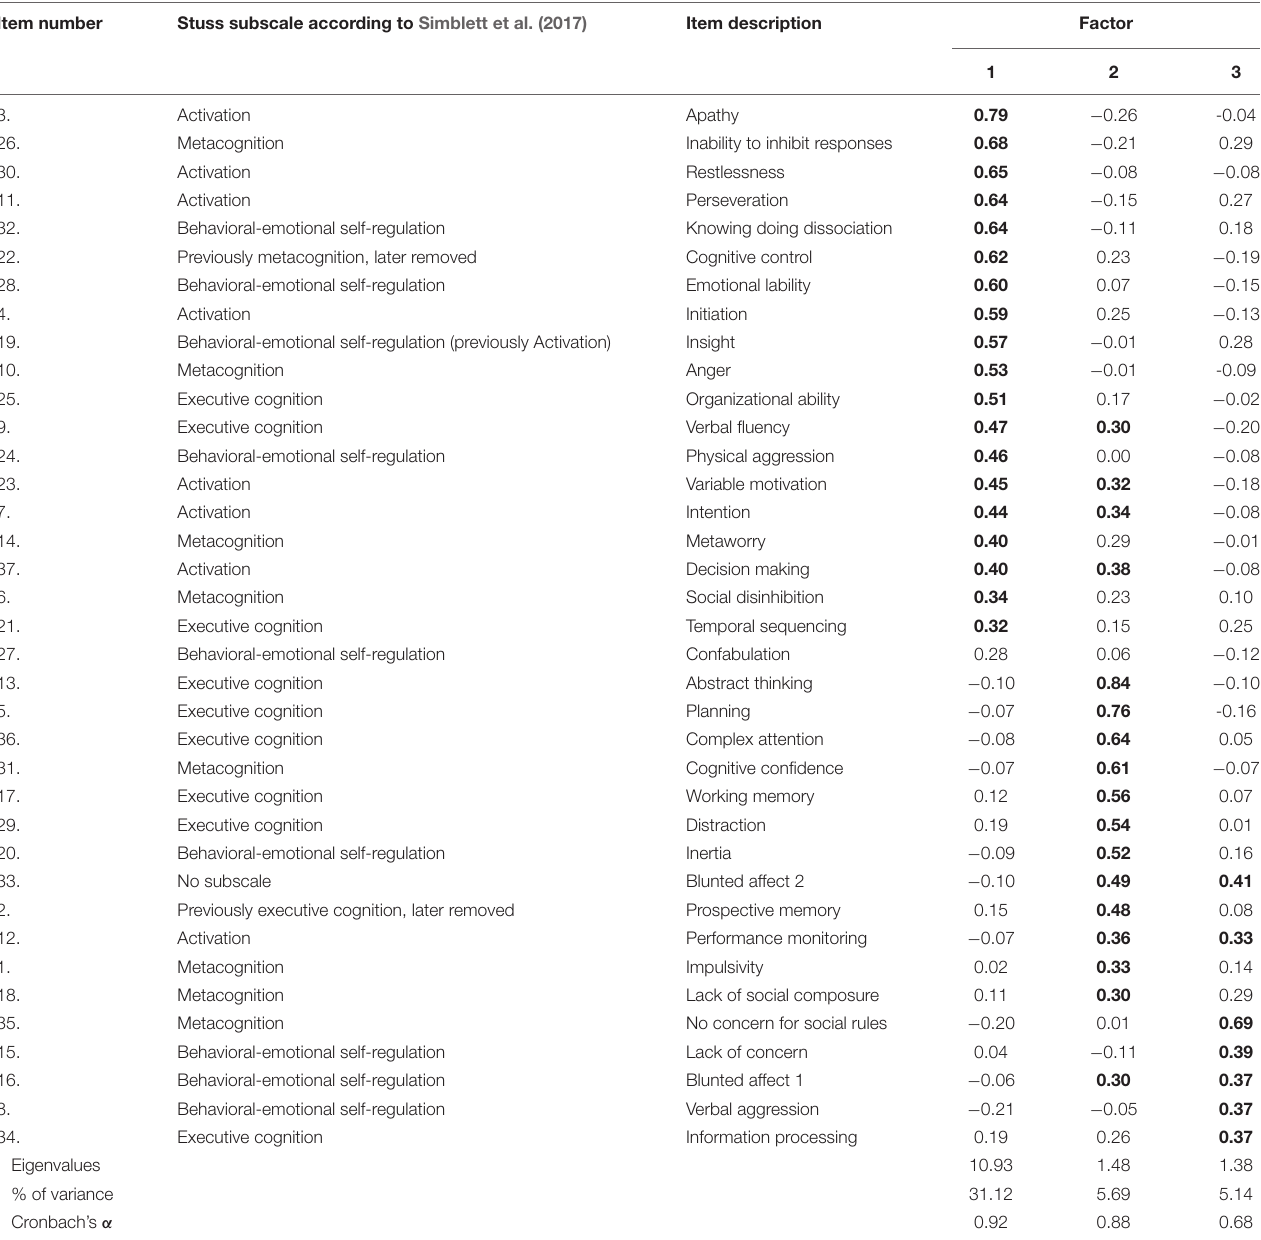
TABLE 2 | DEX-R items according to Stuss subscales and EFA with Promax